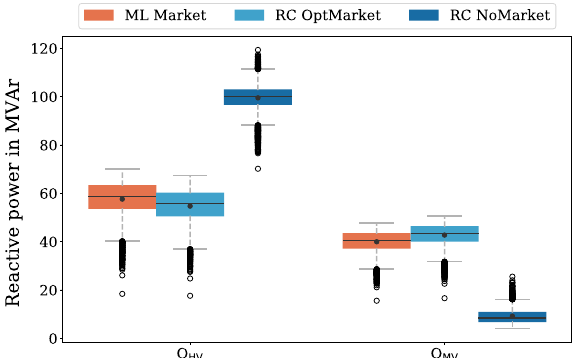
Fig. 6 Total reactive power provided by providers subdivided by the voltage levels (Average total reactive power provided: Multi-level market: 97.54 MVAr, RC OptMarket: 97.41 MVAr, RC NoMarket: 108.65